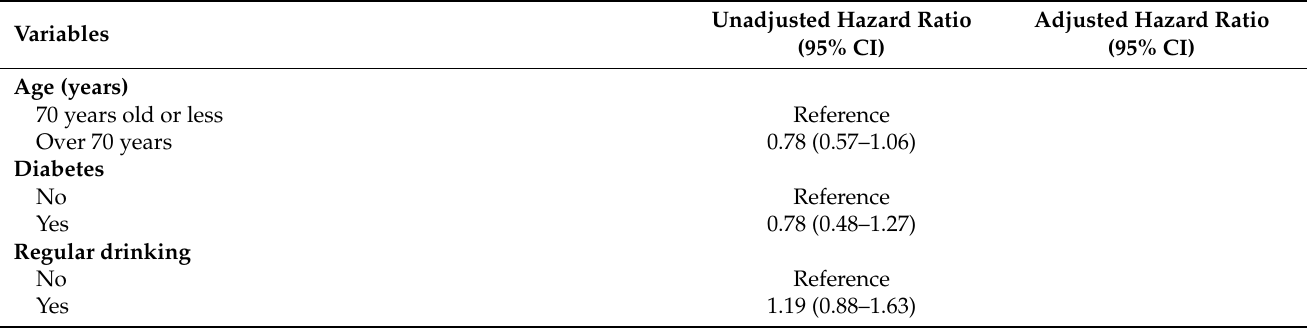
Table 2. Cox proportional hazard regression model for recovery from postoperative urinary inconti- nence without multiple